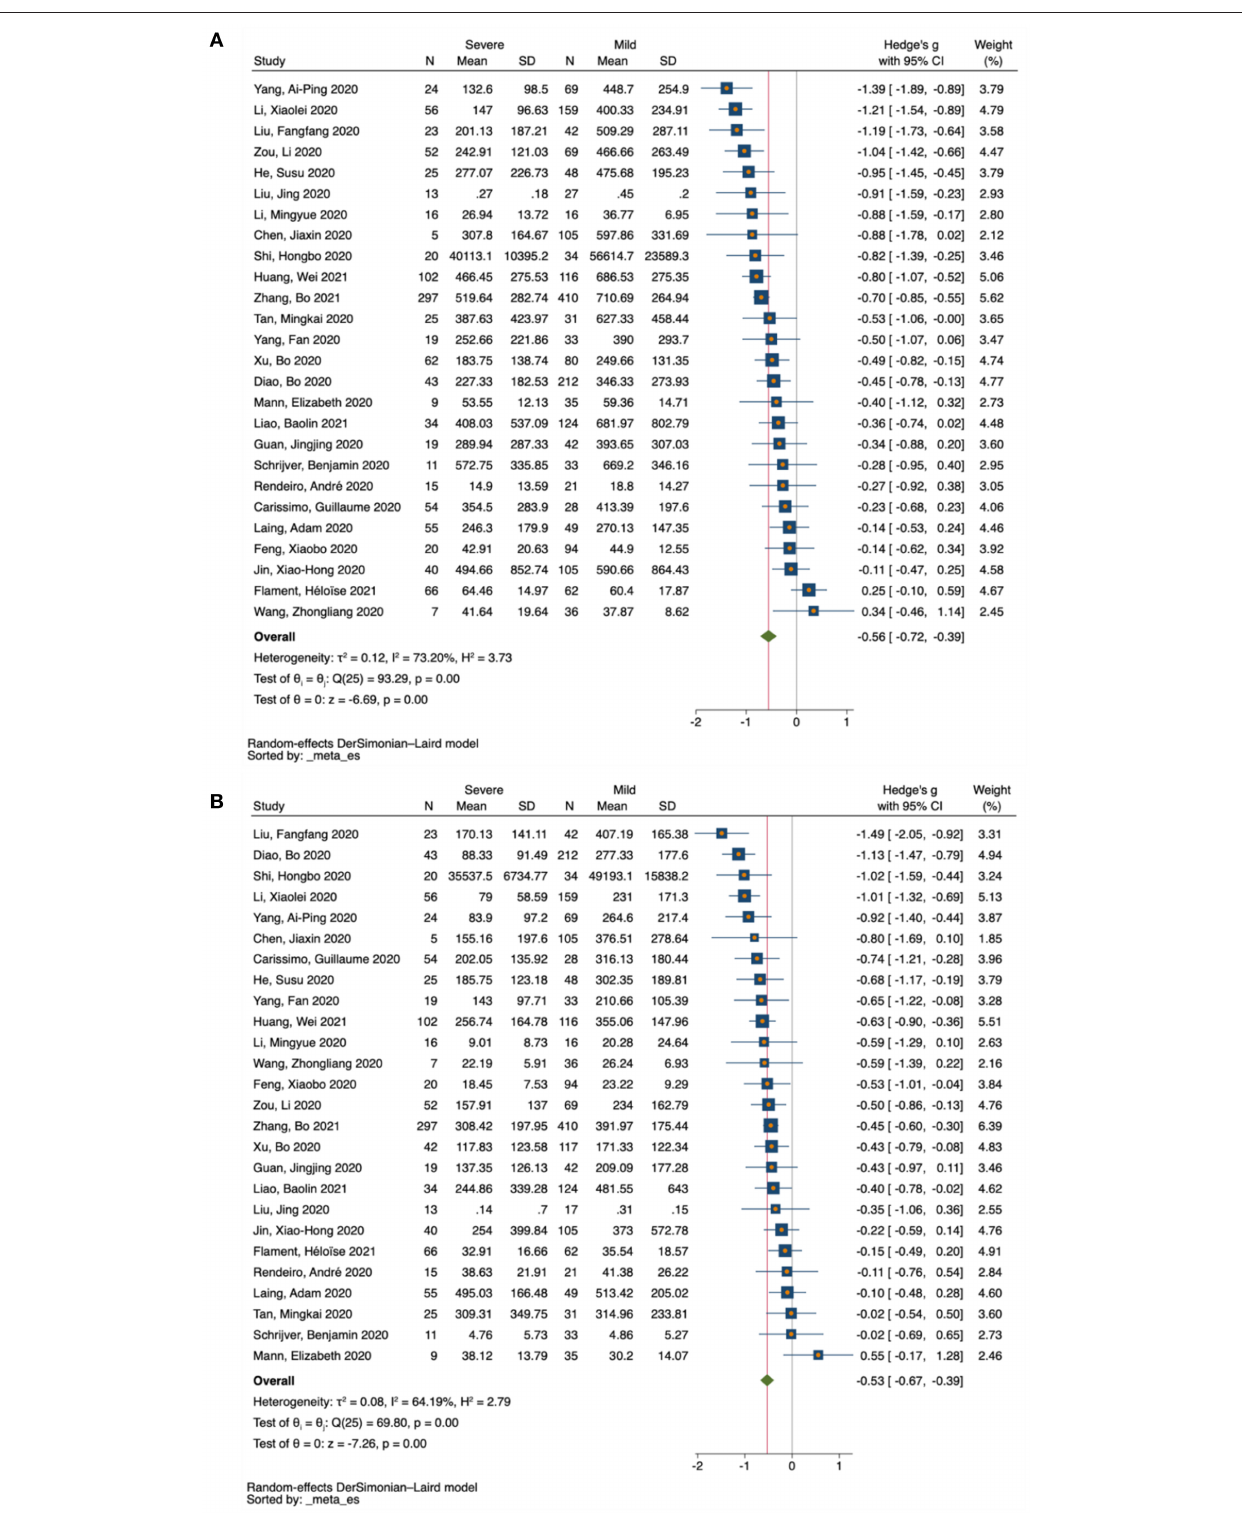
FIGURE 3 | Forest plot of T-cell subsets in COVID-19 severity studies. (A) CD4 T-cells in COVID-19 severity studies. (B) CD8 T-cells in COVID-19 severity studies. The no-effect line is represented at the value of zero. The diamond symbol represents estimated combined effect size.